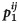
Entropy and p1ij in a LIF model.a, Scheme of a leaky integrate-and-fire model composed of two neurons with intrinsic and extrinsic connections. Neurons N1 and N2 receive inputs from an afferent population of 400 excitatory and 100 inhibitory neurons, which contains an exclusive population (Pob1 and Pob2 projecting to neurons N1 and N2 respectively) and a common populations (Pobc) where each afferent excitatory and inhibitory neuron projects both to N1 and N2. Moreover, neurons N1 and N2 are reciprocally connected through an excitatory synaptic weight Wr. b-c, Effect of changing the mean firing rate of the excitatory afferent population (λEx) and Wr in the entropy (b) and p1ij (c). An increment in λEx and Wr causes a significant rise in entropy, while p1ij remains constant if λEx is increased while decreasing Wr at the same time. d, A trajectory in (Wr, λEx) space that allows to increase entropy efficiently is depicted as a blue arrow. The red arrow implies increments in λEx only. Light and dark grey lines represent level curves for constant entropy and constant p1ij respectively. A simultaneous increment in efficiency and entropy requires increasing λEx while reducing Wr in such a way that the change in p1 tends to zero. e-f, Efficiency and entropy for points 1, 2 and 3 of trajectories shown in (d). Efficiency increases for the blue trajectory, and decreases for the red trajectory. All comparisons within trajectories are significantly different (N = 30 repetitions, P<1x10-3, sign test).